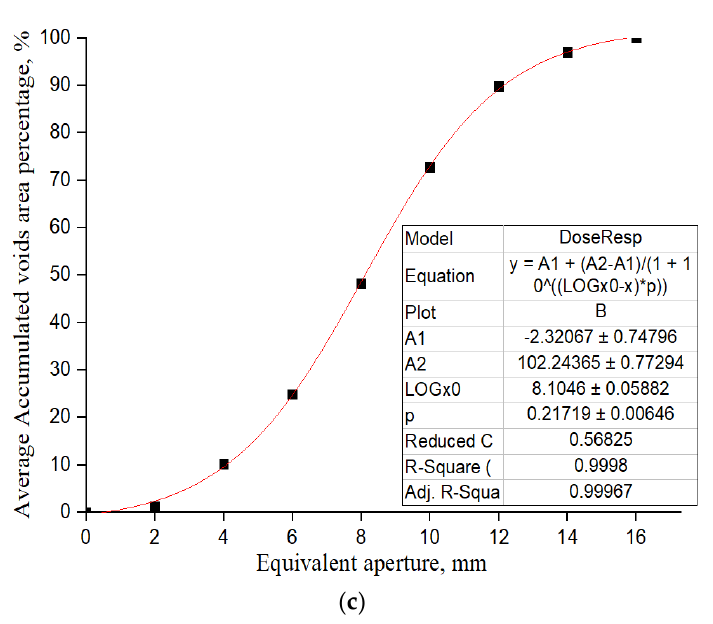
Figure 13. The relationship between the accumulated voids areas and the equivalent aperture along horizontal sections , ( a ) OGFC sample I, ( b ) OGFC sample II, ( c ) Average value of OGFC samples.